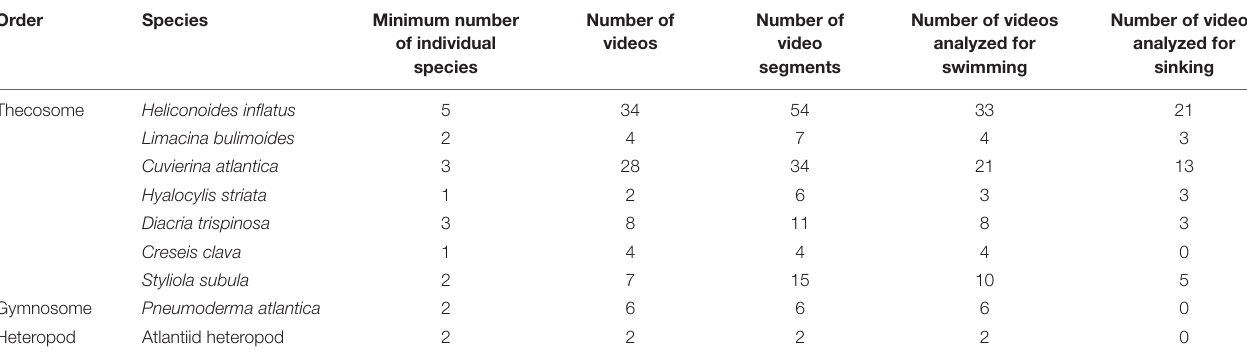
TABLE 1 | Number of individual animals, videos, and video segments analyzed for each marine snail